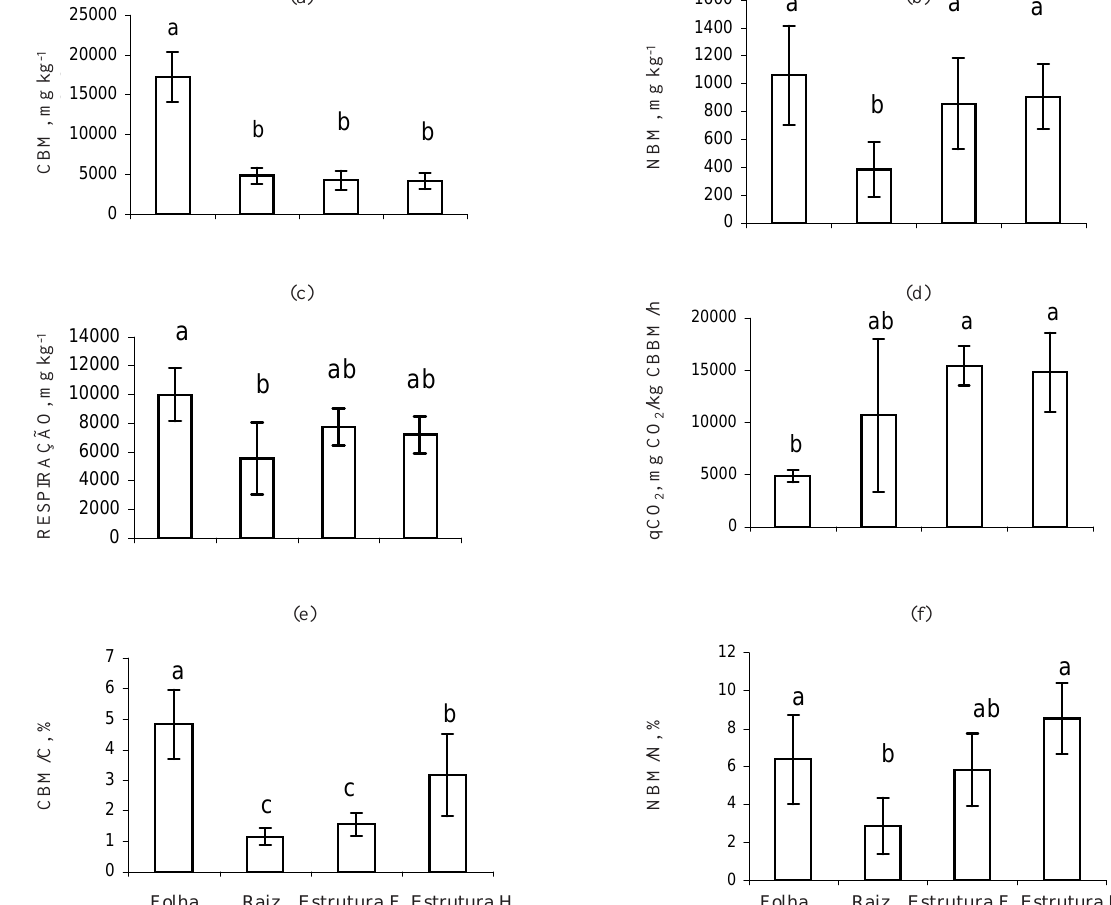
Figura 1. Atributos microbiológicos das diferentes estruturas da serapilheira: CBM (carbono da biomassa microbiana), NBM (N-ninidrina da biomassa microbiana), RA (respiração microbiana acumulada), qCO (quociente metabólico), C/N mic (relação CBM/NBM), Cmic/Corg (relação CBM/C orgânico), 2 Nmic/Ntotal (relação NBM/N